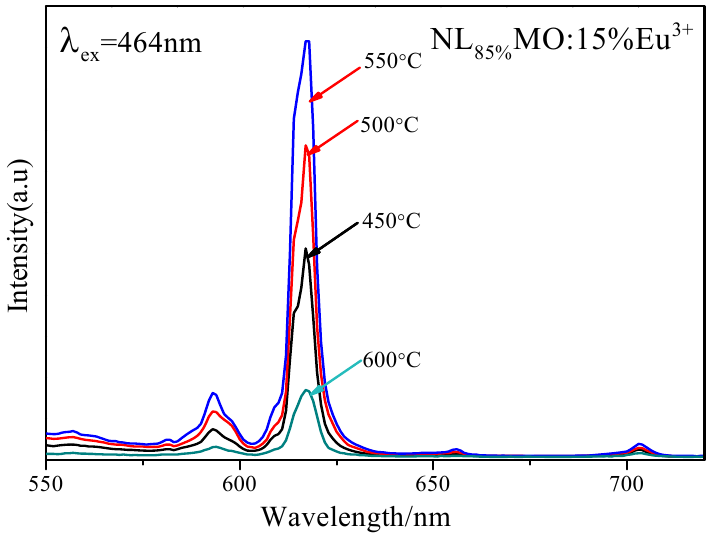
Figure 4. Emission ( λ ex = 464 nm) spectra of NL 85% MO:15%Eu 3+ obtained at different calcination temperatures.